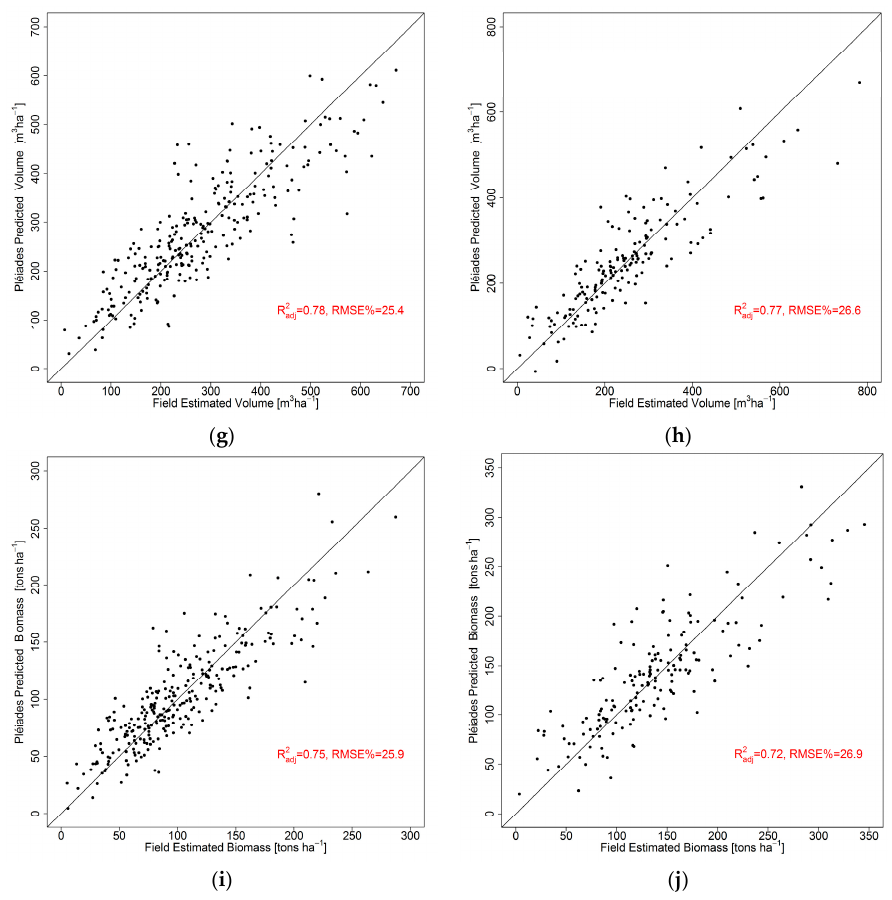
Figure 6. ( a – j ) Scatter plots of models of the five target variables described in Table 6. Krycklan ( a , c , e , g , i ) and Remningstorp ( b , d , f , h , j